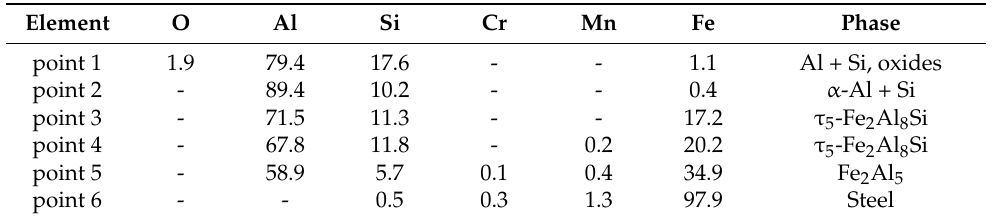
Table 2. The results from the SEM-EDS point analysis, presented as atomic percentages, and the corresponding phase